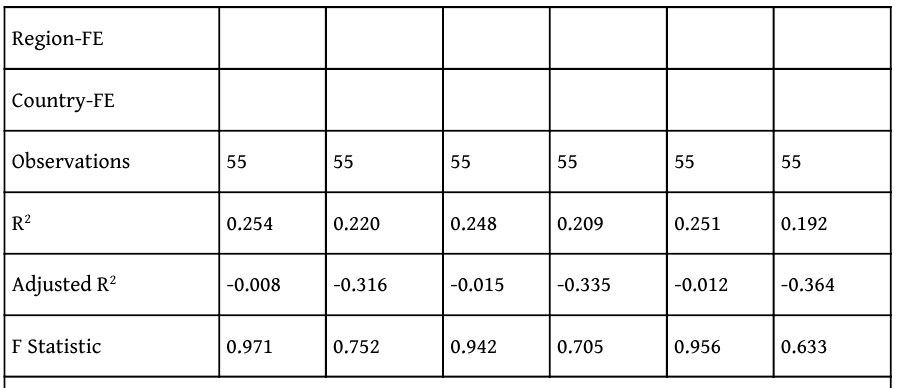
Figure A1 : FDI openness in the CEECs by country (1990-2018)